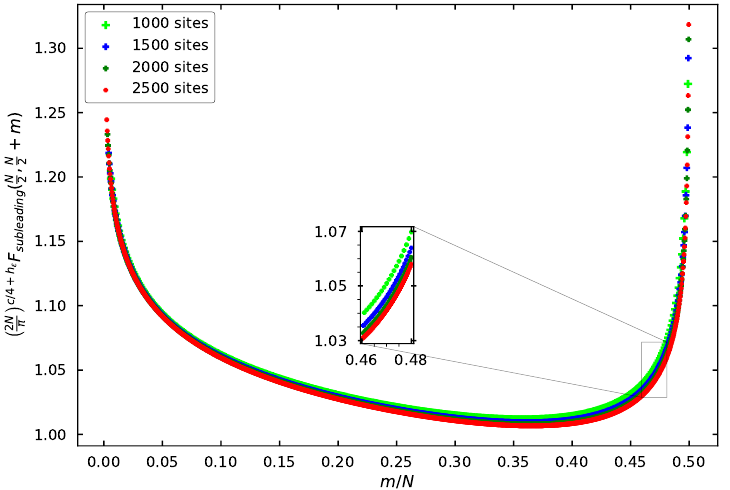
Figure 6: The rescaled subleading contribution ( 2 N /π ) c / 4 + h (cid:34) F two-point function of twist fields, for an interval starting in the middle of the chain and growing towards one boundary. The plot shows that even at large system sizes, the finite-size corrections are